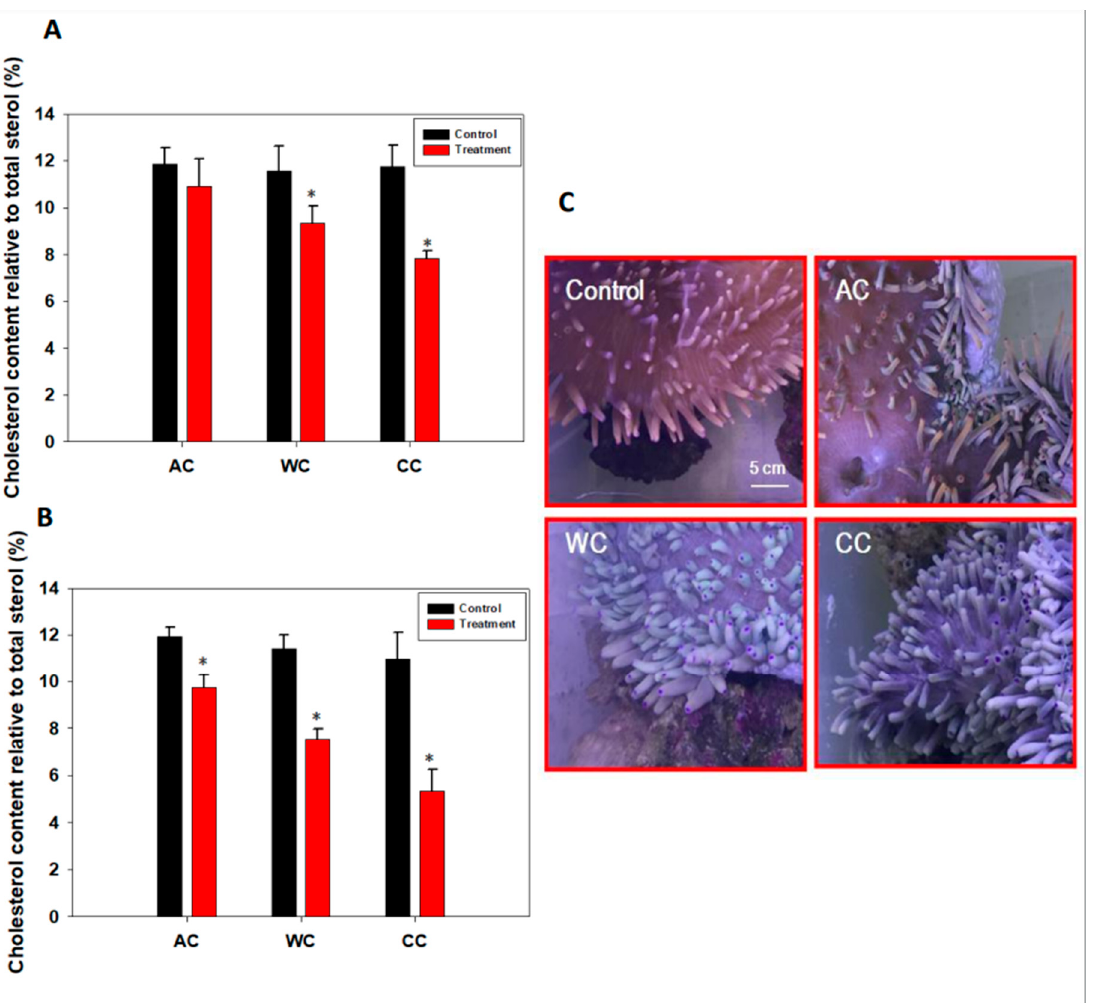
Figure 3. Changes in levels of symbiont cholesterol and the phenotype of H. crispa . in response to stress. ( A ) Changes in levels of symbiont cholesterol on day 3 ( n = 3); ( B ) Changes in levels of symbiont cholesterol on day 15 ( n = 3); ( C ) Phenotype of H. crispa in response to stress. AC, acidification conditions; WC, warming conditions; CC, combined conditions. Asterisks (*) indicate p -values < 0.05.